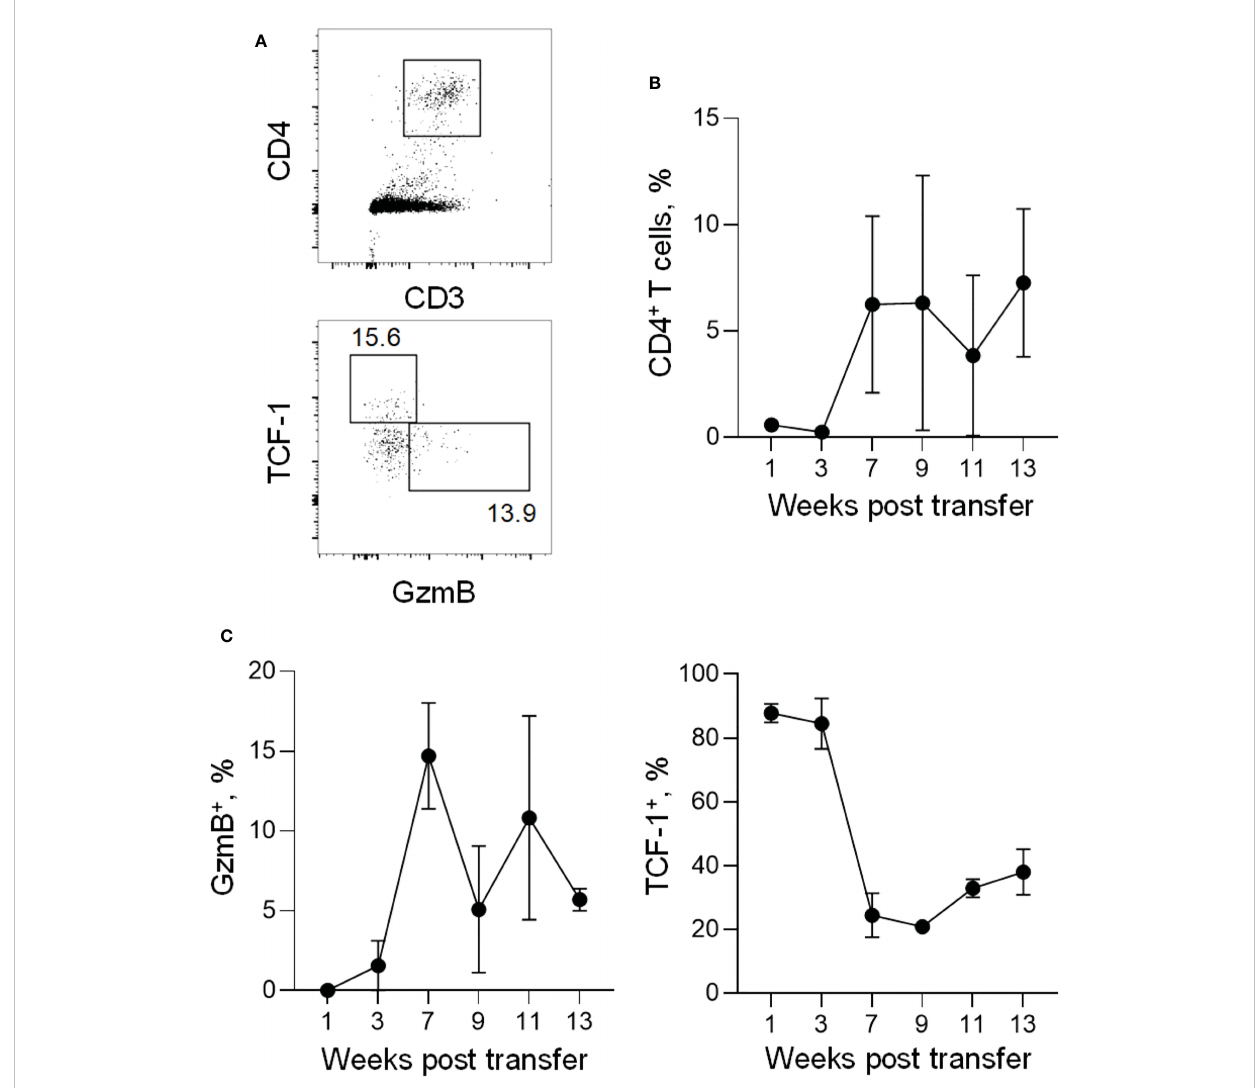
FIGURE 5 Expansion and persistence of xenografted human CD4 + CTLs. (A) Flow-cytometric detection of human CD4 + T cells (top) and GzmB + and TCF-1 + CD4 + T cells (bottom) in peripheral blood of recipient triple KO mice injected with human PBMCs. (B) Frequency of human CD4 + T cells within single cells in peripheral blood (for weeks 1-11) or within splenocytes (week 13) of recipient triple KO mice at indicated time points after adoptive transfer. (C) Frequency of GzmB + cells (left) or TCF-1 + cells (right) within total human CD4 + T cells in peripheral blood (weeks 1-11) or splenocytes (week 13) of recipient triple KO mice at indicated time points after adoptive